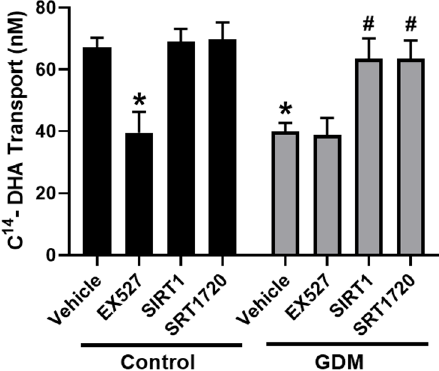
Figure 6. Effect of SIRT1 on DHA transfer through the trophoblasts exposed to control and GDM conditions. Primary human trophoblasts were cultured in Transwell inserts in standard conditions or with medium containing 25-mmol / L glucose and 10 − 7 -mol / L insulin for 72 h. Cells cultured in control conditions were treated with SIRT1 inhibitor (EX527, 1 µ mol / L) for 24 h. Cells cultured under GDM conditions were treated with recombinant SIRT1 (50 ng / L) or SIRT1 activator (SIRT1729, 1 µ mol / L) for 24 h. Transfer of 14C-DHA (1 µ Ci / mL) from the apical to the basal chamber was measured using liquid scintillation counting. Data are expressed as mean ± SD of three independent experiments. * p < 0.05 vs. vehicle in control conditions. # p < 0.05 vs. vehicle in GDM